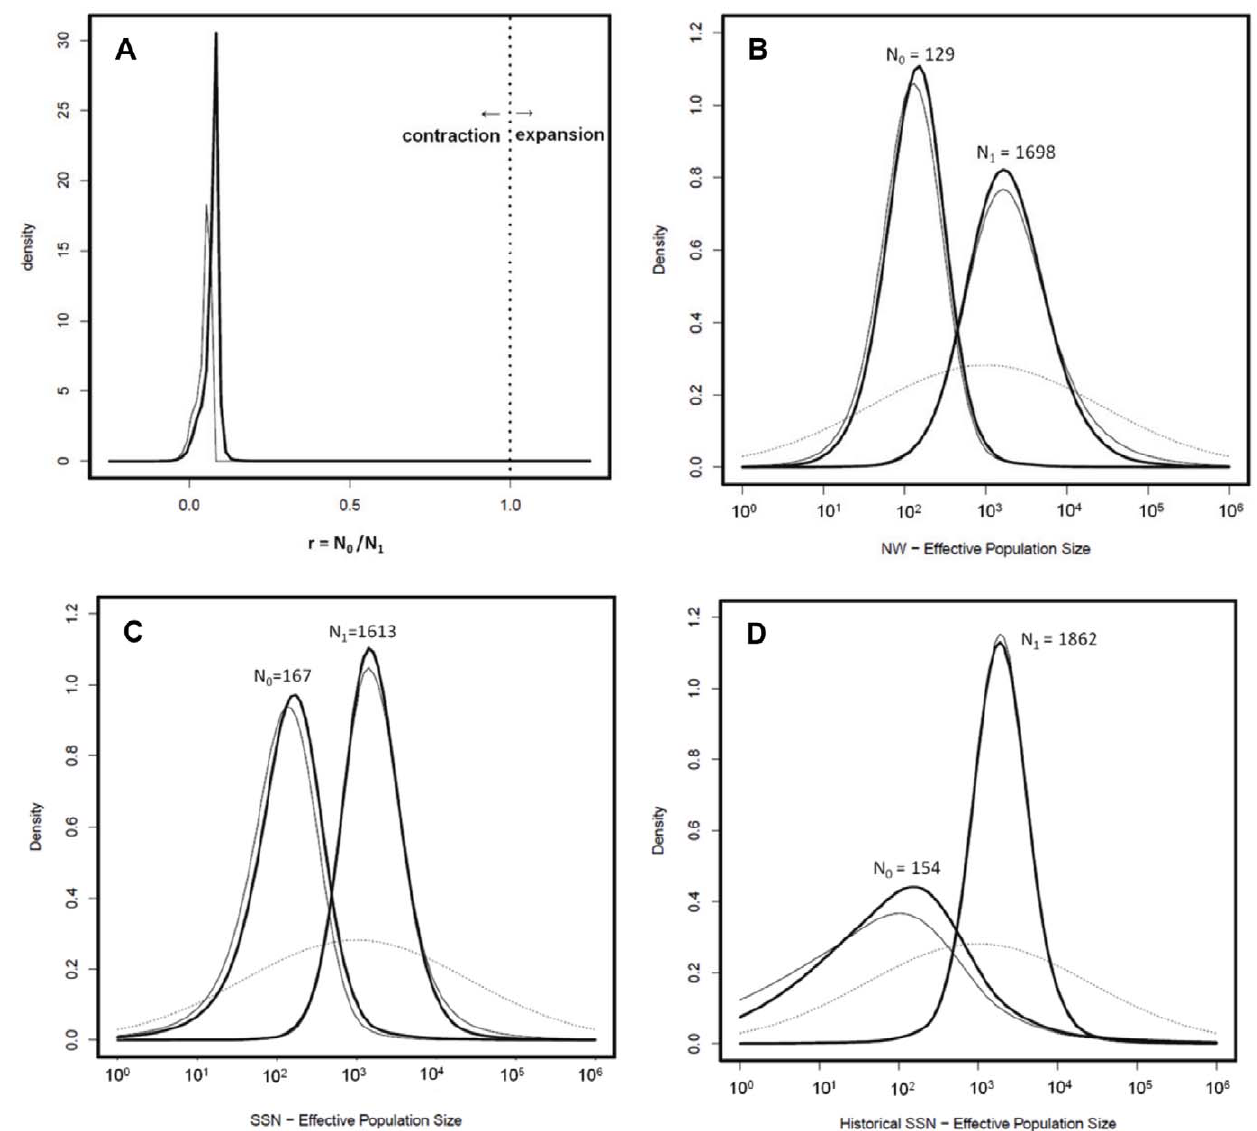
Figure 4. MSVAR results: population size change. A) ratio of current and ancestral population sizes (r= N 0 / N 1 ) where r=1 signifies population stability, r , 1 decline, and r . 1 expansion. 4B–D) Posterior distributions of the current ( N 0 ) and ancestral ( N 1 ) effective population size using both the exponential (thick lines) and linear (thin lines) models: B) northwestern-historical, C) southern Sierra Nevada-contemporary, and D) southern Sierra Nevada-historical. The dotted line shows the prior distribution for N 0 and N 1